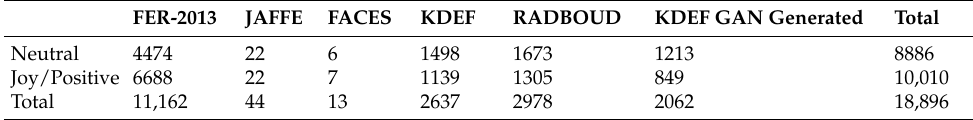
Table 4. Training data for positive and neutral classes (Model